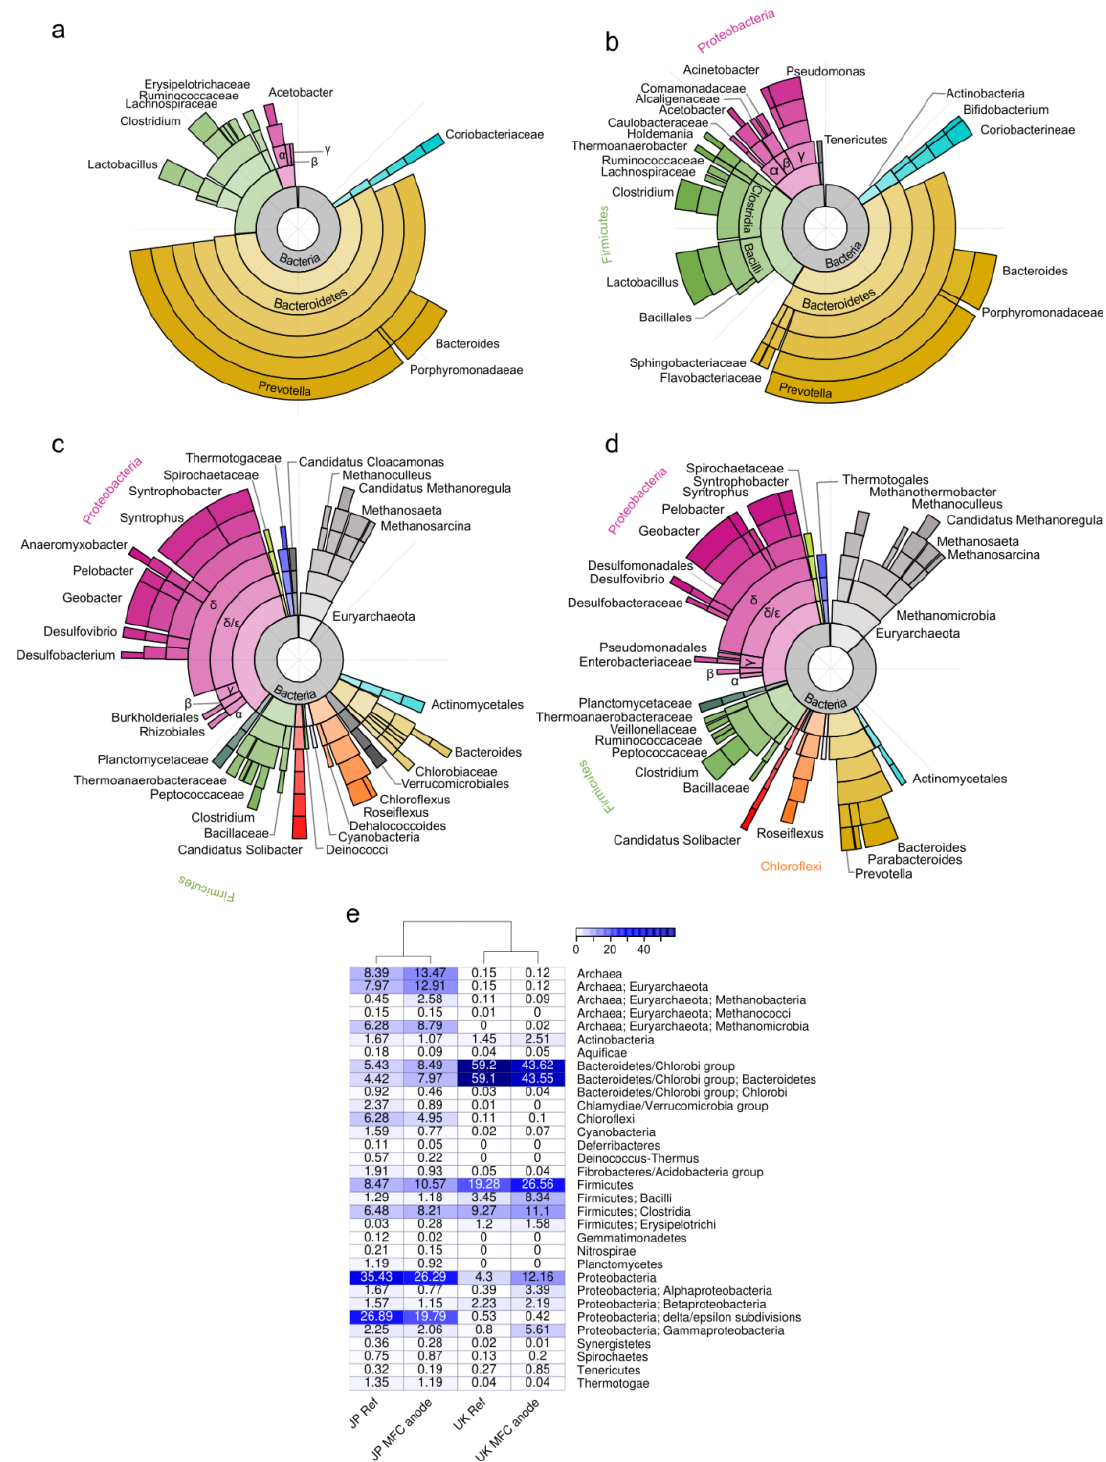
Figure 2: Phylogenetic profile of MFC microbiomes. Krone-like diagrams for UK ref (a), UK anode (b), JP ref (c), JP anode (d) represents the abundance of different phylogenetic groups within a sample where each circle represents taxonomic level, and colored according to the phylum level or group level (level 3 in NCBI taxonomy): yellow – Bacteroidetes/Chlorobi group, purple – Proteobacteria , light grey – Archaea , green – Firmicutes , orange – Chloroflexi , red – Acidobacteria , green-yellow – Spirochaetes , dark blue – Thermotogae , light blue – Actinobacteria , dark green – Planctomycetes , light pink – Cyanobacteria . (e) Heatmap representing the abundance of different phylogenetic groups on the level of phylum and class for most abundant groups; the numbers represent the percentage of abundance of a particular group in the